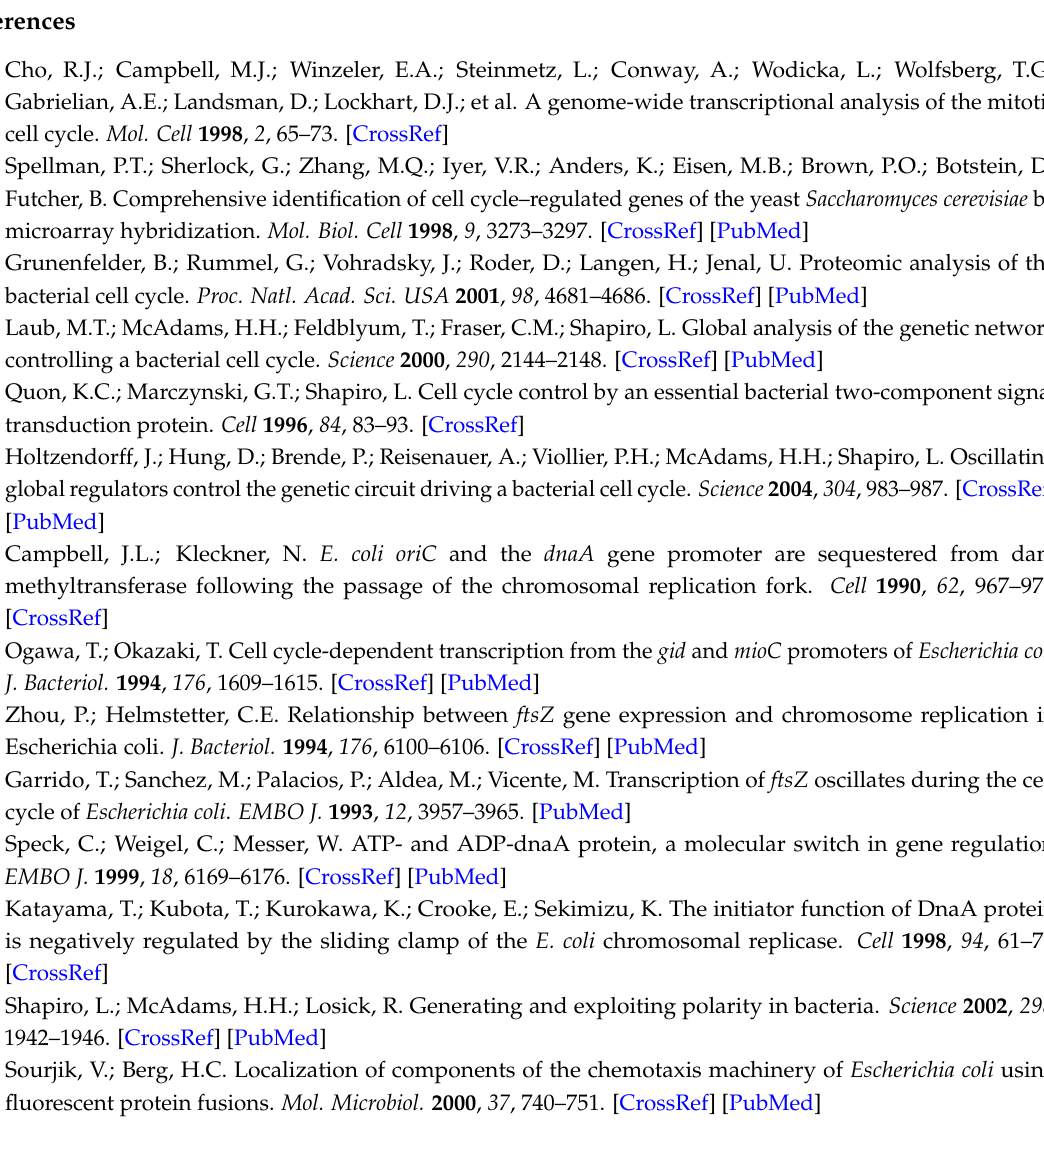
Supplementary Materials: All supplementary data are available online at www.mdpi.com/2073-4425/8/1/01/s1, Movie S1: Subcellular localization of TorR-GFP in live cells. Figure S1: TorR polar focus is distinct from inclusion bodies, Figure S2: Polar TorR-GFP remains soluble upon temperature-shifts, Figure S3: The wild-type TorR regulates expression of genes in a cell-cycle-dependent manner, Figure S4: The SDS-PAGE gel analysis of proteins bound to GFP antibody on GFP-Trap beads, Figure S5: Subcellular localizations of the TorR-GFP in 6 mutants, Figure S6: MreB is required for localization of TorR at the old pole of cell, Figure S7: Protein-protein interactions were detected by a bacterial two-hybrid system, Figure S8: Subcellular localizations of the proteins pulled-down with TorR-GFP, Figure S9: The truncated TorR-GFP protein is expressed at the same level as the wild-type TorR-GFP, Table S1: Expression of genes at the 45 min time point relative to that at 0 min time after release from initiation-arrest in either presence or absence of TorR, Table S2: Proteins pulled-down with TorR-GFP, Table S3: Bacterial strains, Table S4: Plasmids, Table S5: Primers